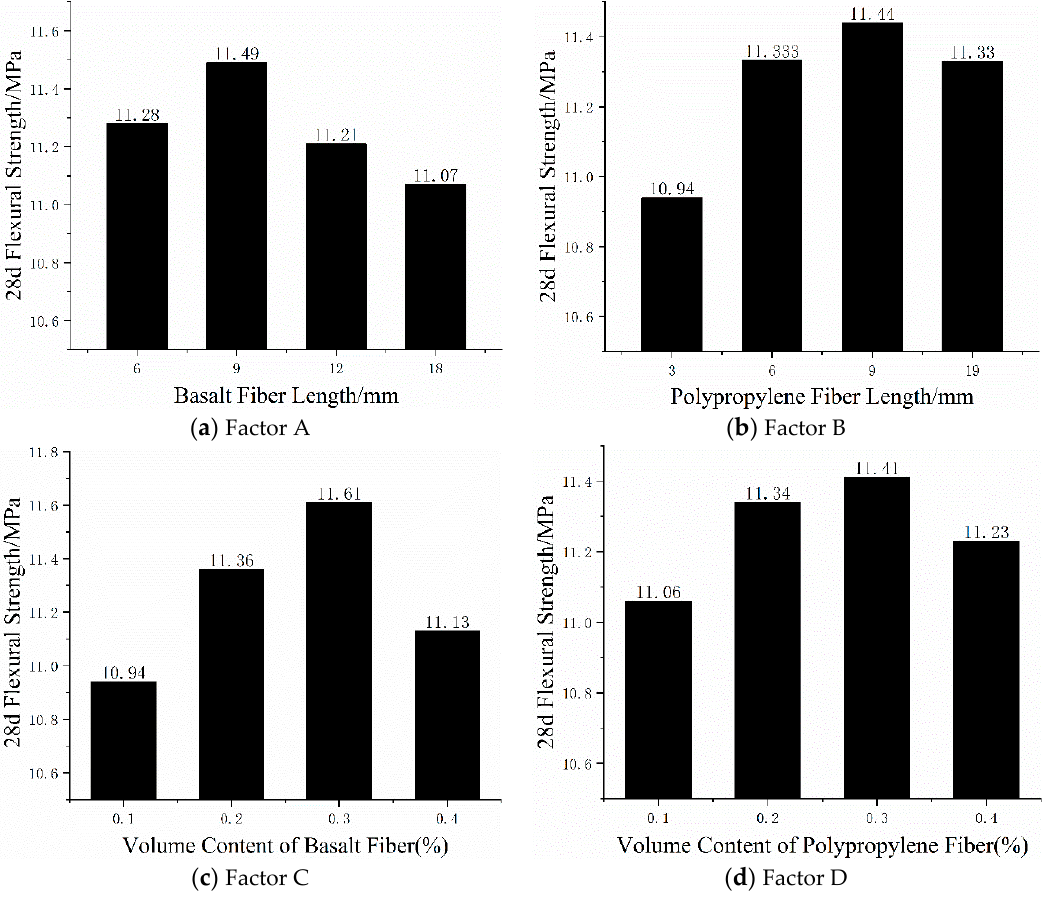
Figure 5. Relationship between four factors and flexural strength.